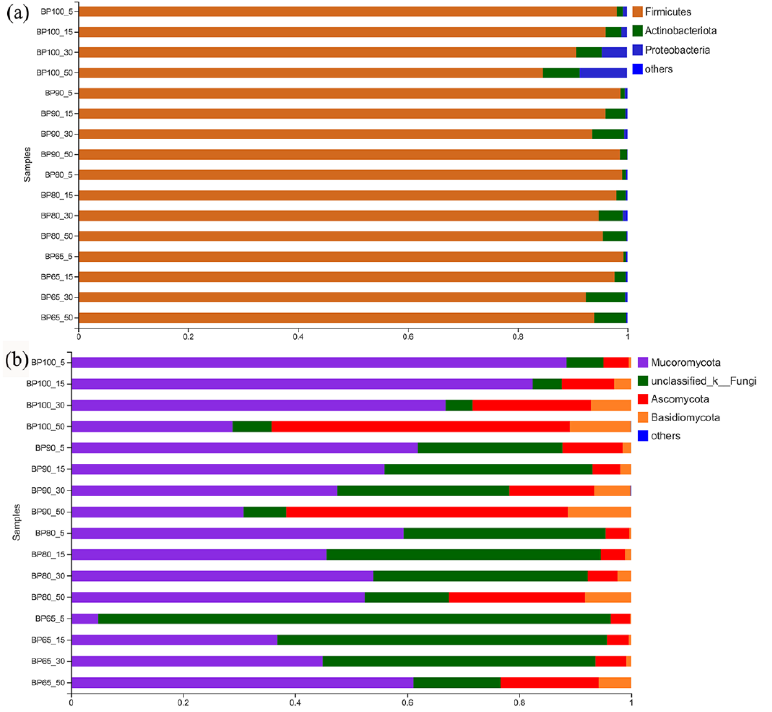
Figure 3. The relative abundances of bacterial ( a ) and fungal community ( b ) structure at phylum levels.